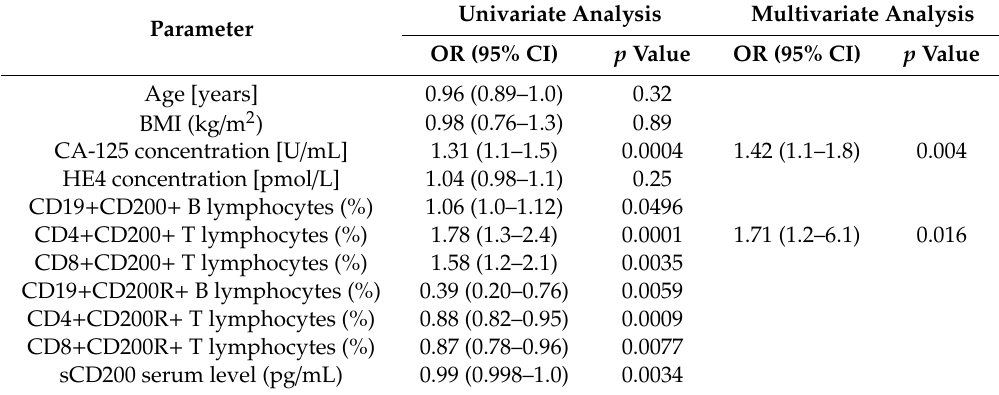
Table 7. Results from the univariate and multivariate analyses for the identification of risk factors associated with